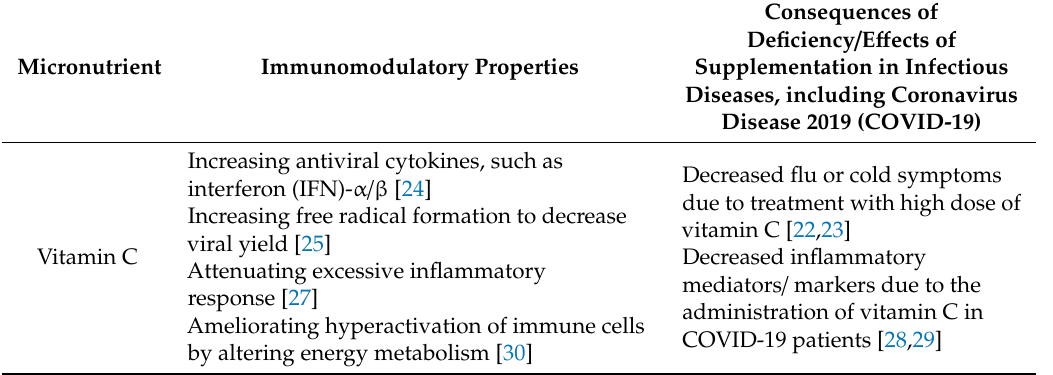
Table 1. The e ff ect of micronutrients on the immune system against viral infectious